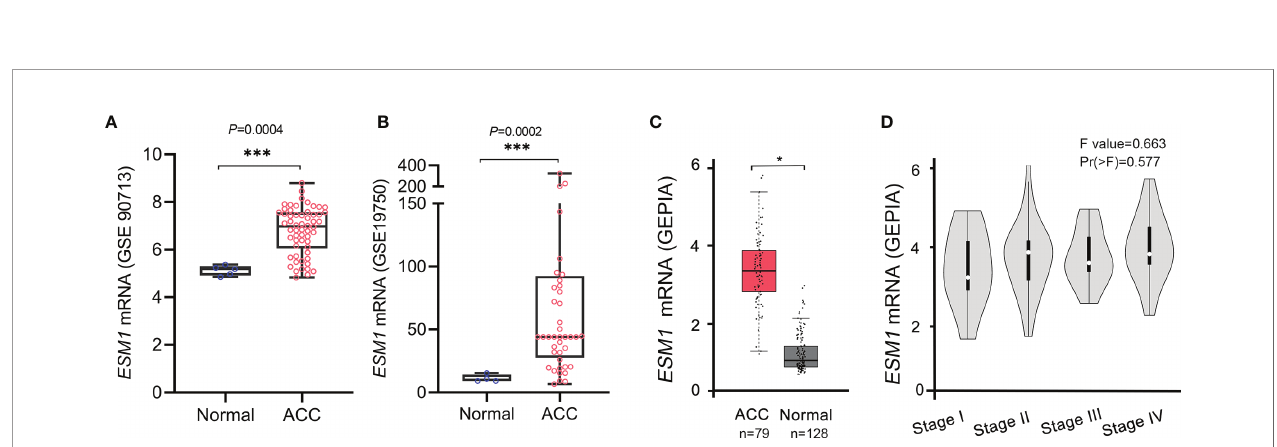
FIGURE 2 | Based on GEO and TCGA datasets, ESM1 was overexpressed in ACC patients, compared with normal adrenocortical tissues. The expression of ESM1 from (A) GSE90713 and (B) GSE19750. Relative expression of ESM1 in ACC, normal tissues (C) , and in tumor stages I – IV (D) based on GEPIA online server. * p < 0.05, *** p <